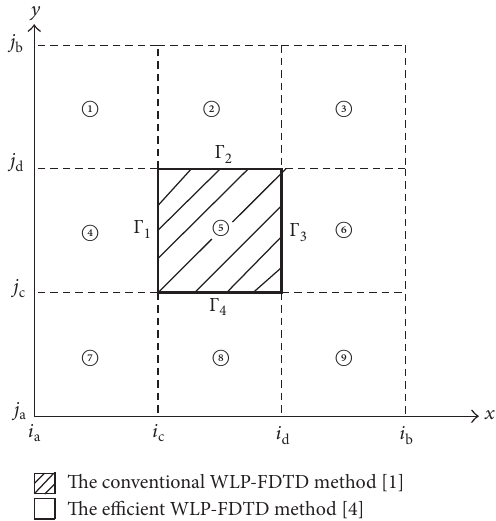
Figure 1: Nine subdomains in the computational domain.